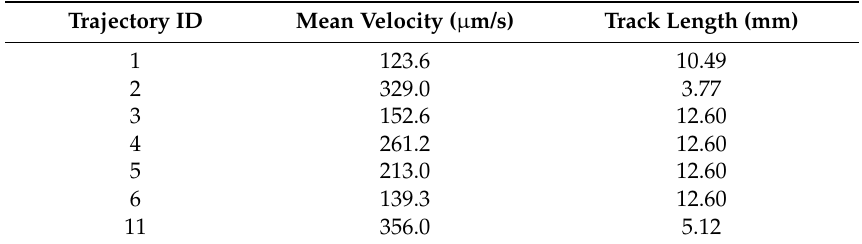
Table 3. Motility trajectories of Schistosoma mansoni miracidia after egg hatching in water Analysis of video recording (Figure 2) by image analysis software [40].